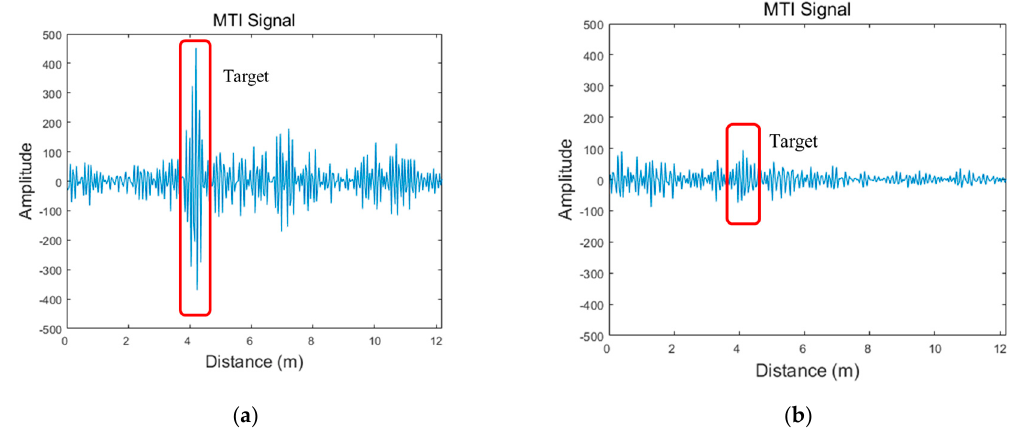
Figure 5. Radar signals at detection stage: ( a ) moving target indicator (MTI) signal with no wall; ( b ) MTI signal through the wall.